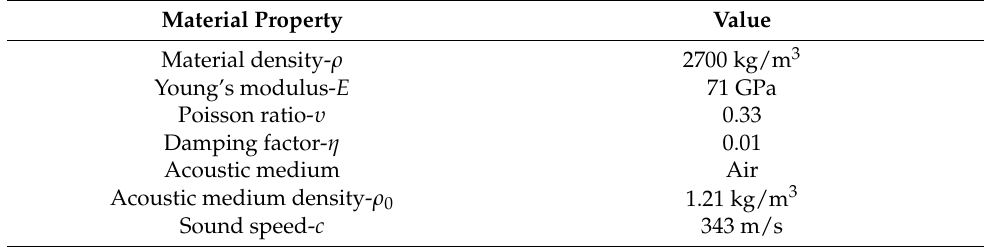
Table 1. Model parameters of the sandwich